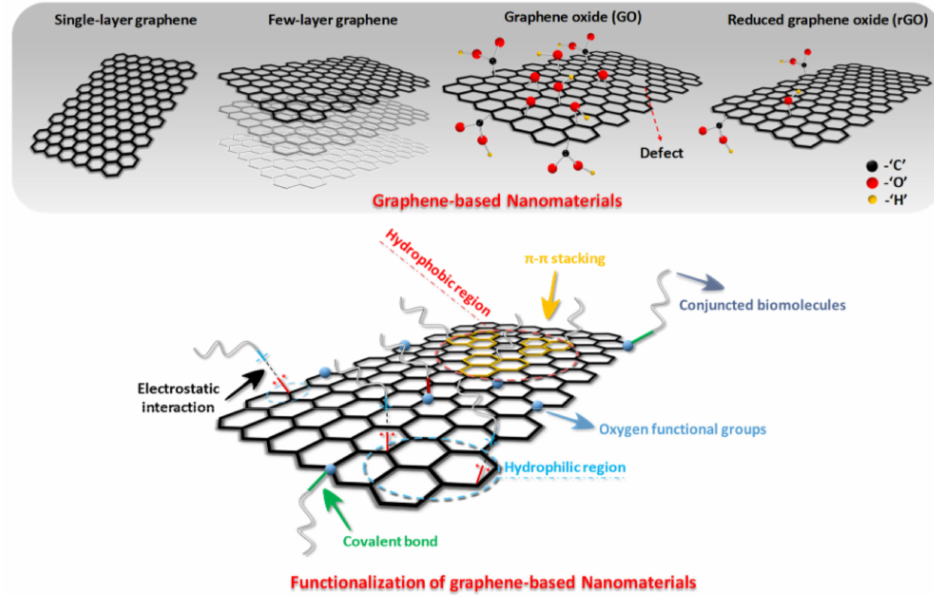
Figure 7. Synthesis of GO and rGO via modification of Gn. Reprinted with permission from